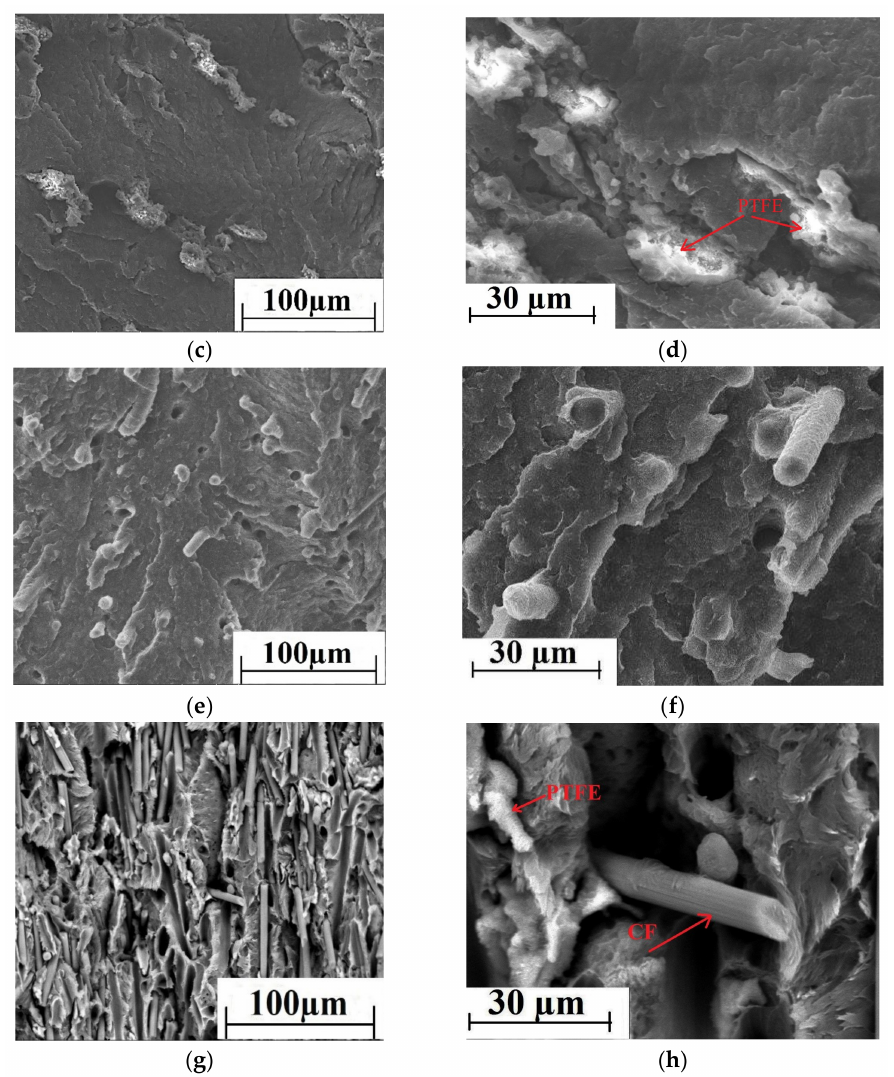
Figure 3. SEM micrographs of the permolecular structure: ( a , b ) PEEK and ( b – h ) the PEEK-based composites (( c,d ) PEEK + 10% PTFE, ( e,f )–PEEK + 10% CF, and ( g,h ) PEEK + 10% PTFE + 10%